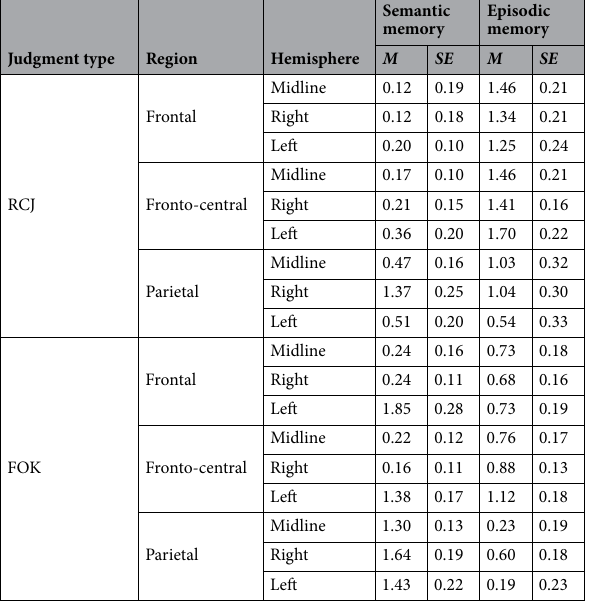
Table 1. Mean and standard error according to memory task, judgment type, region and